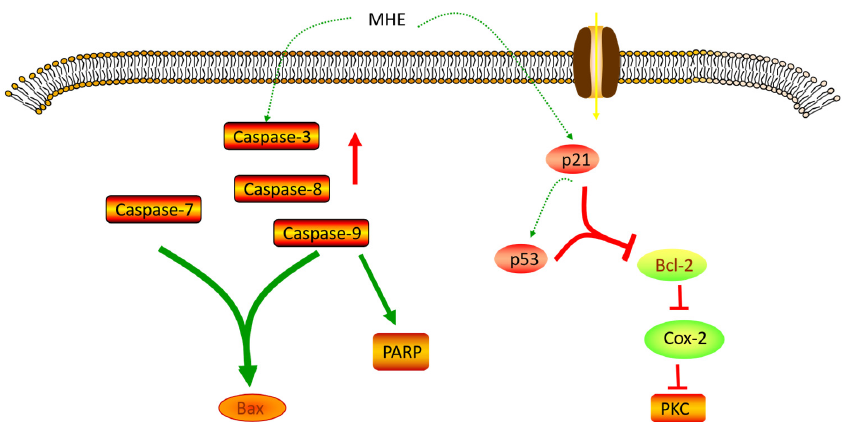
Figure 3. Anticancer mechanism of